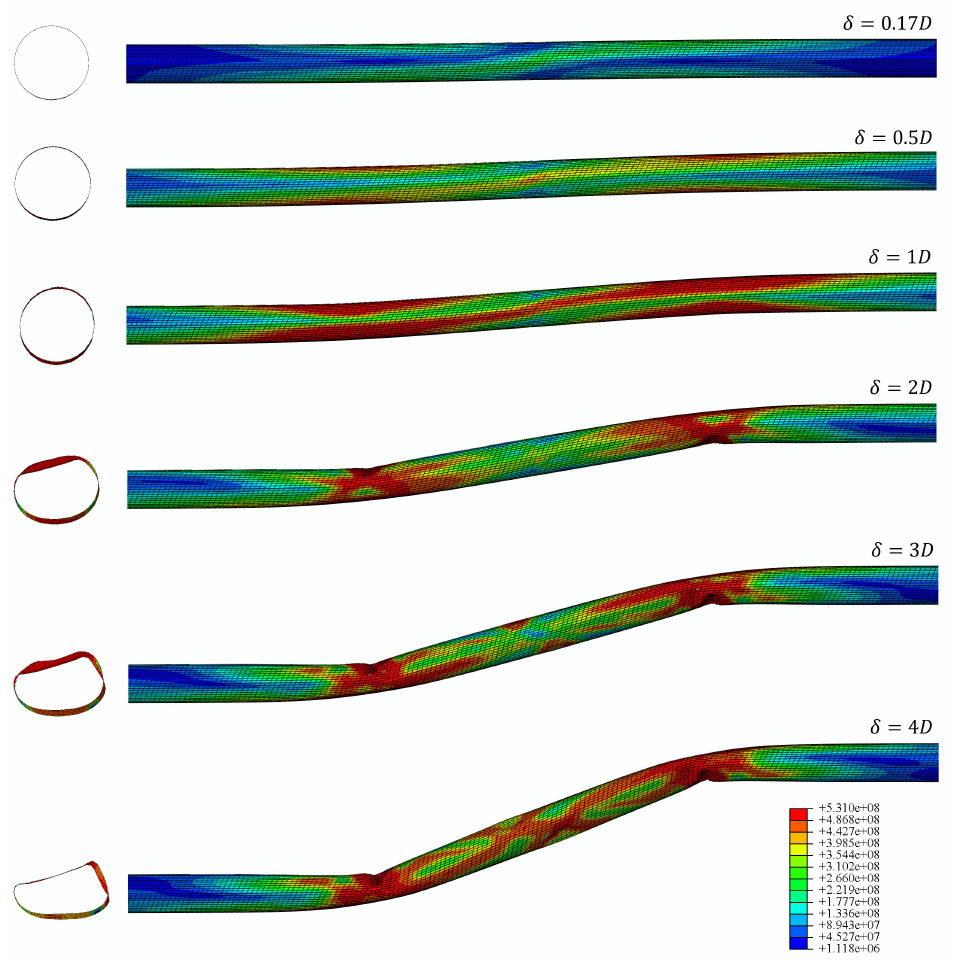
Figure 14. The Mises stress response and buckled cross-section of a buried pipeline at a 60 ◦ strike-slip fault crossing in the 3D solid model for cases with fault movements of 0.17D, 0.5D, 1D, 2D, 3D, and